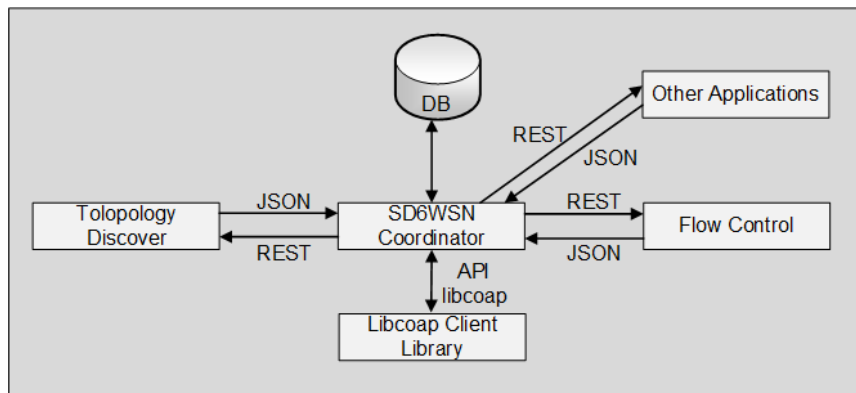
Figure 4. Diagram of the interaction of the controller